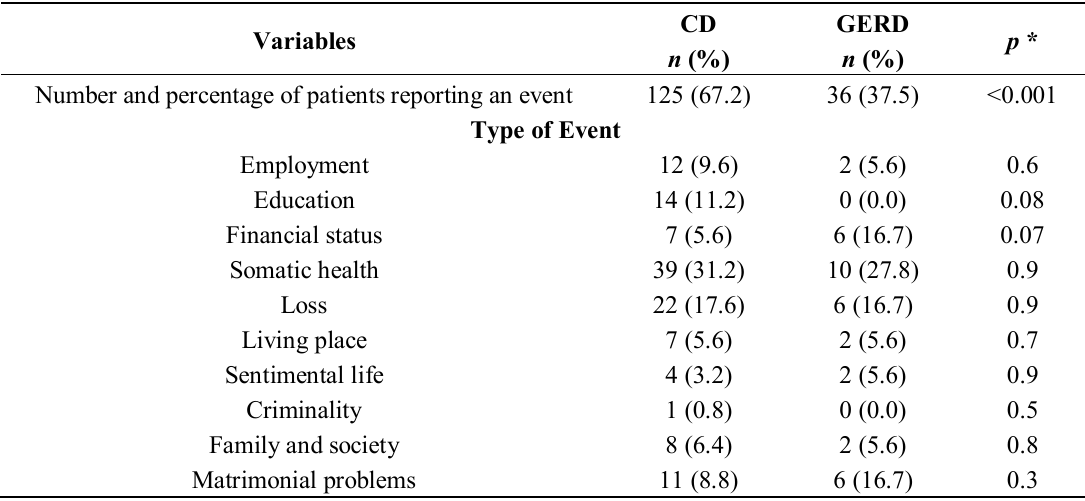
Table 2. Distribution of life events among the 10 areas identified by the Paykel Scale in CD and control (GERD)